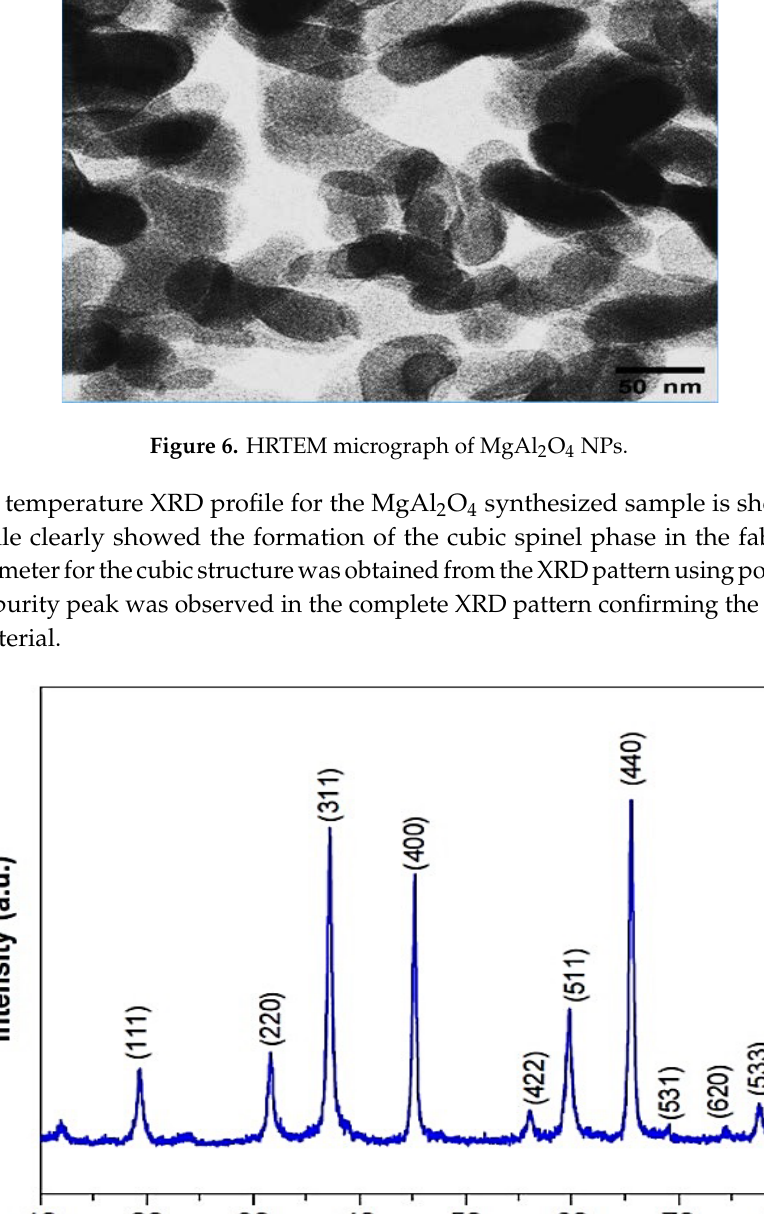
Figure 7. XRD pattern of MgAl 2 O 4 NPs.